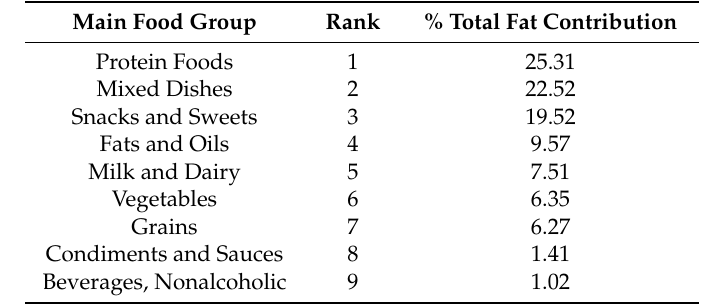
Table 13. Food sources of total fat contribution in the total U.S. diet, adults ≥ 51 years old ( n = 4522; gender combined; daily intake data; NHANES 2011–2014; main food groups contributing <1.0% not reported; data are Day 1 intakes).